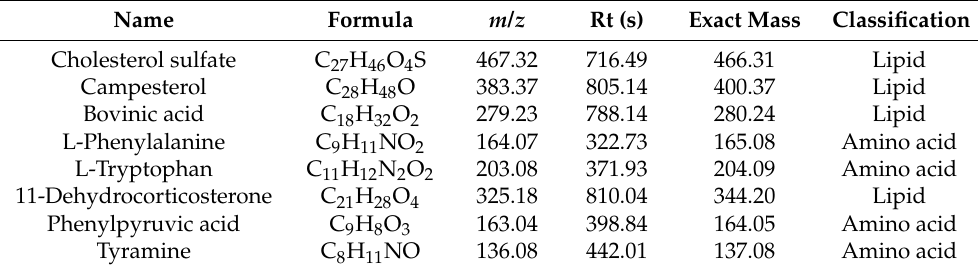
Table 3. Basic information on differential